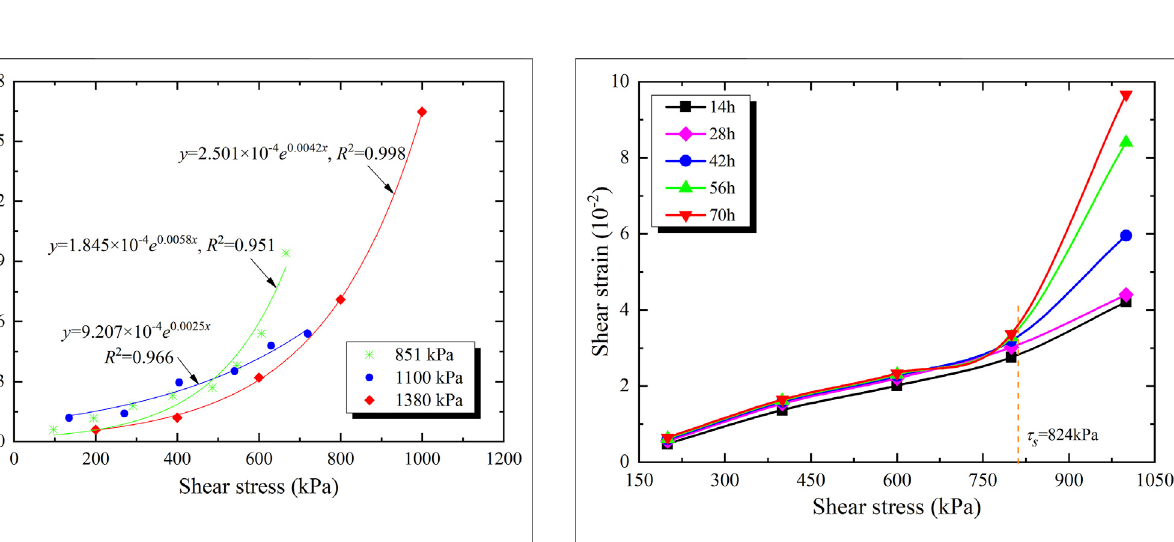
Isochronous curve cluster graph of sample